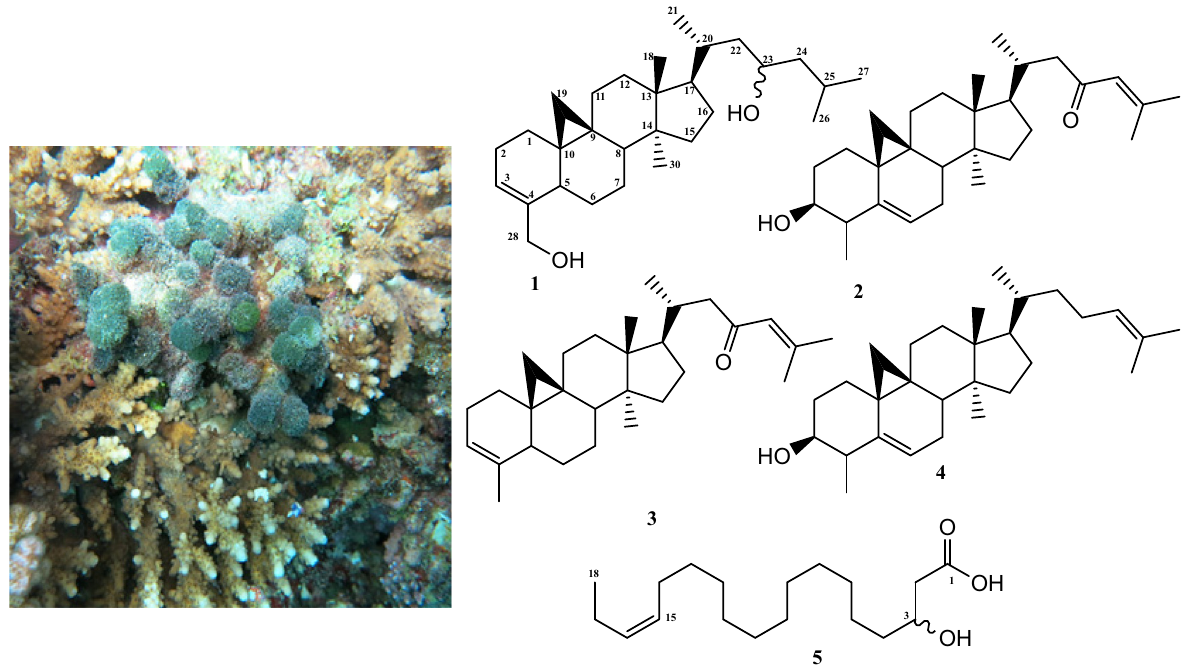
Figure 1: Molecular structures of compounds 1 – 5 isolated from Tydemania expeditionis